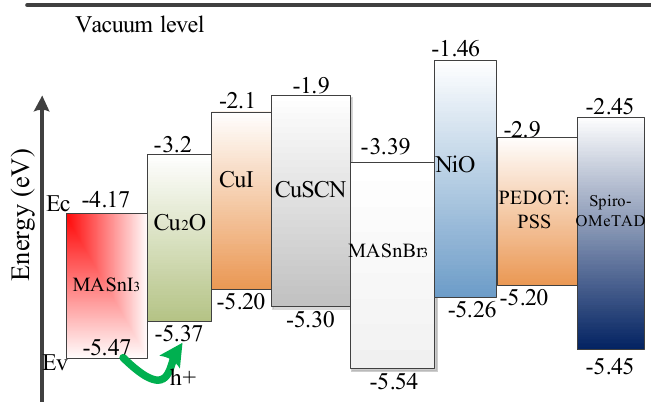
Figure 7. Band alignment between HTL materials and MASnI 3 perovskite. Table 5. Responses of PSCs with different HTL materials.